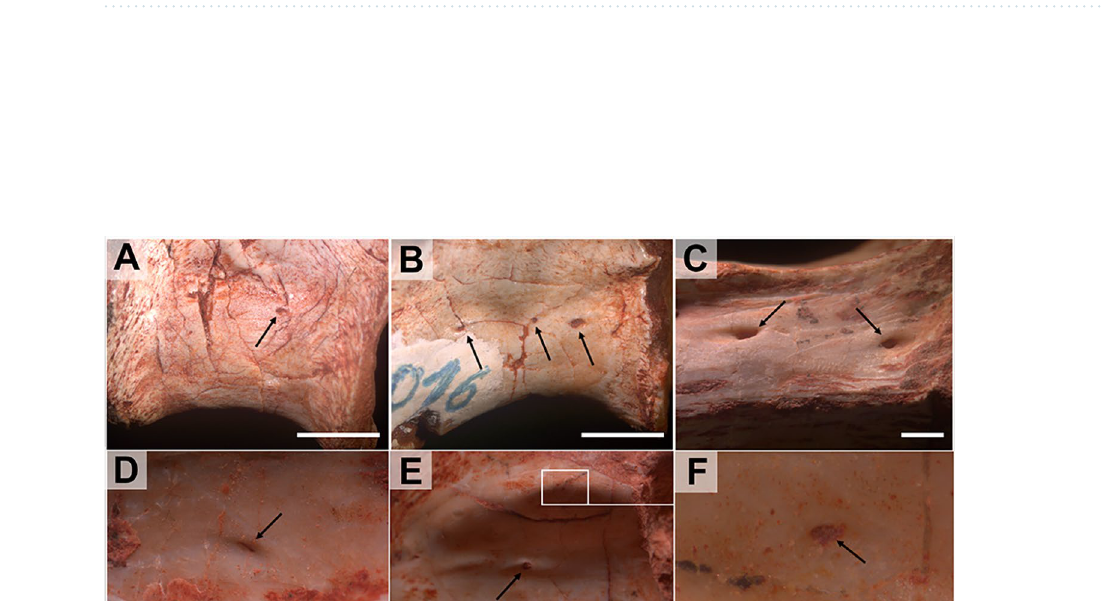
Figure 2. Detail of the vertebrae and foramina of the basalmost sauropodomorph Buriolestes (CAPPA/UFSM- 0035). Cervical ( A – C ), anterior ( D – F ) and posterior ( G – I ) dorsal vertebrae in right lateral view. Note that nutritional foramina are present throughout the axial skeleton (dark arrows). Anterior/posterior orientation was defined based on the axial position, not the anatomical plane. Scale bar = 5 mm. Figures were generated with Adobe Photoshop CC version 22.5.1 X64.